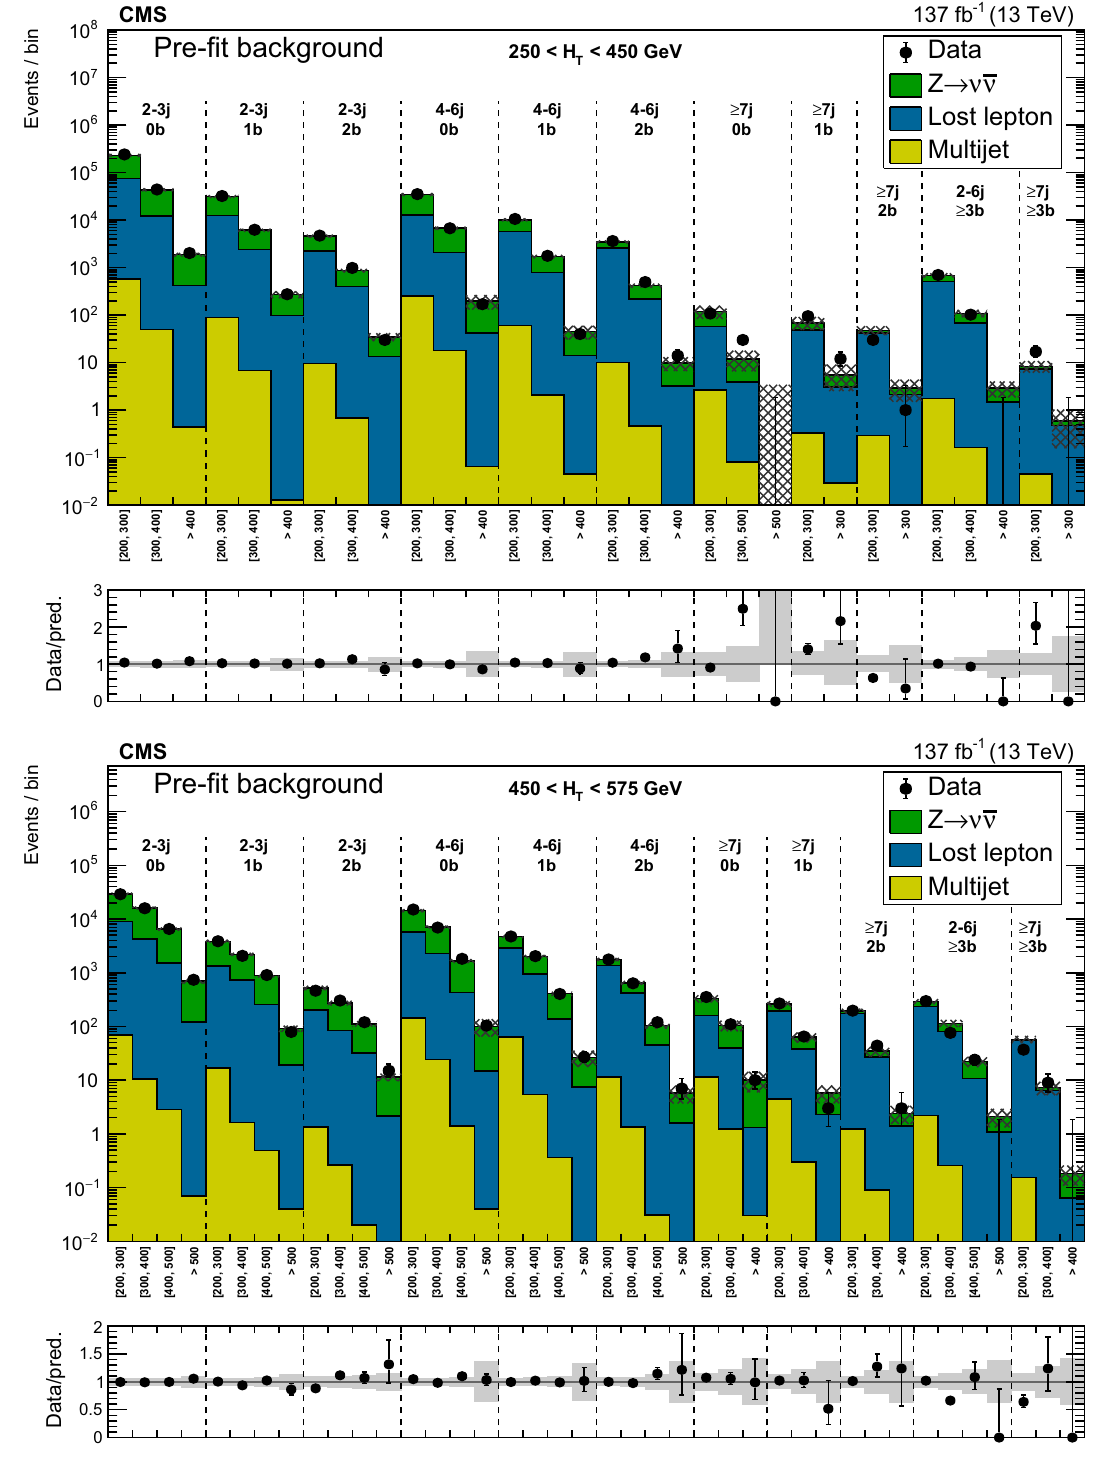
Fig. 23 (Upper) Comparison of the estimated background and observed data events in each signal bin in the very-low- H T region. The hatchedbands represent thefull uncertaintyinthe background estimate.